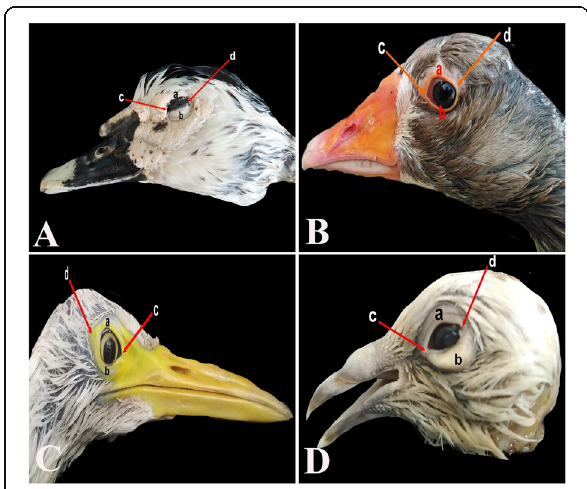
Fig. 1 A photomacrograph of head showing external features of the eye, upper eye lid ( a ), lower eye lid ( b ), anterior canthus ( c ), and posterior canthus ( d ) in duck ( A ), goose ( b ), ibis ( c ), and pigeon ( d )